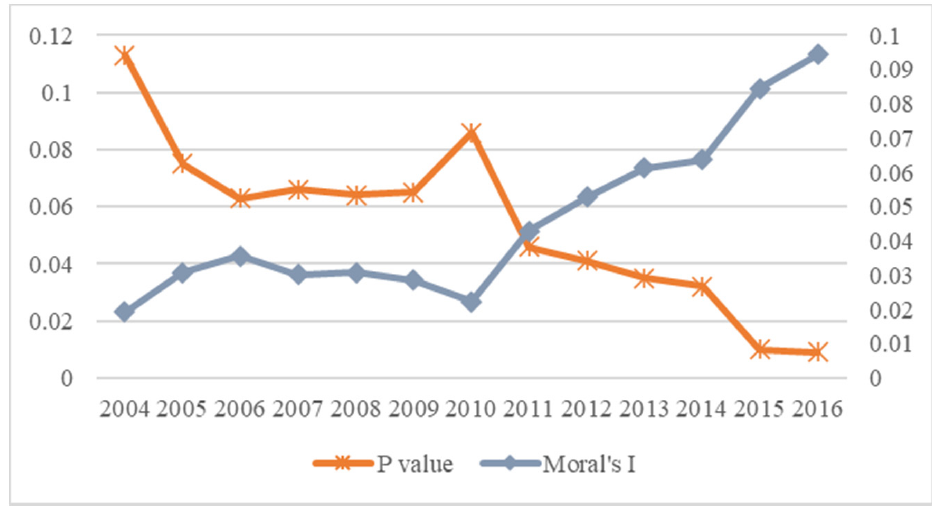
Figure 3. Moran’s I index of urban innovation from 2004 to 2016.